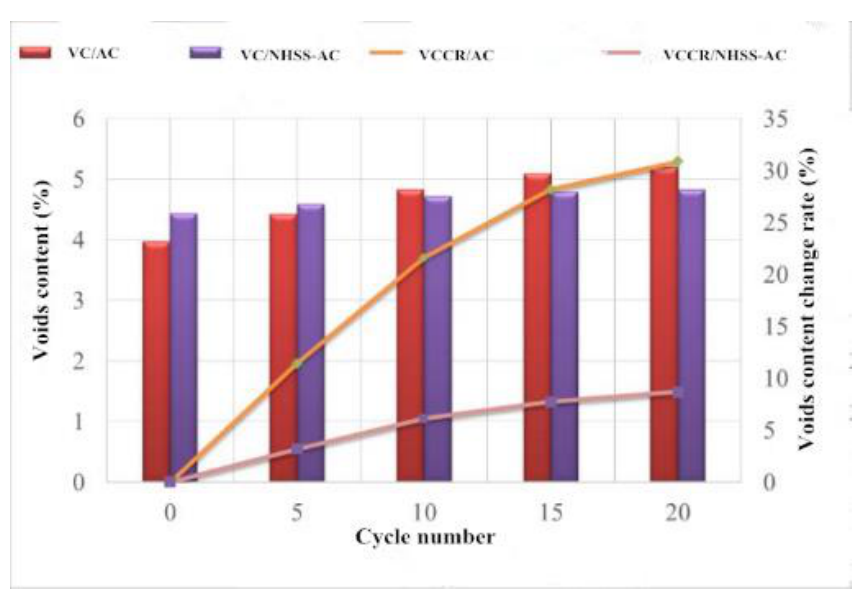
Figure 6. Void content changes of mixtures under freeze – soak – scour cycles.